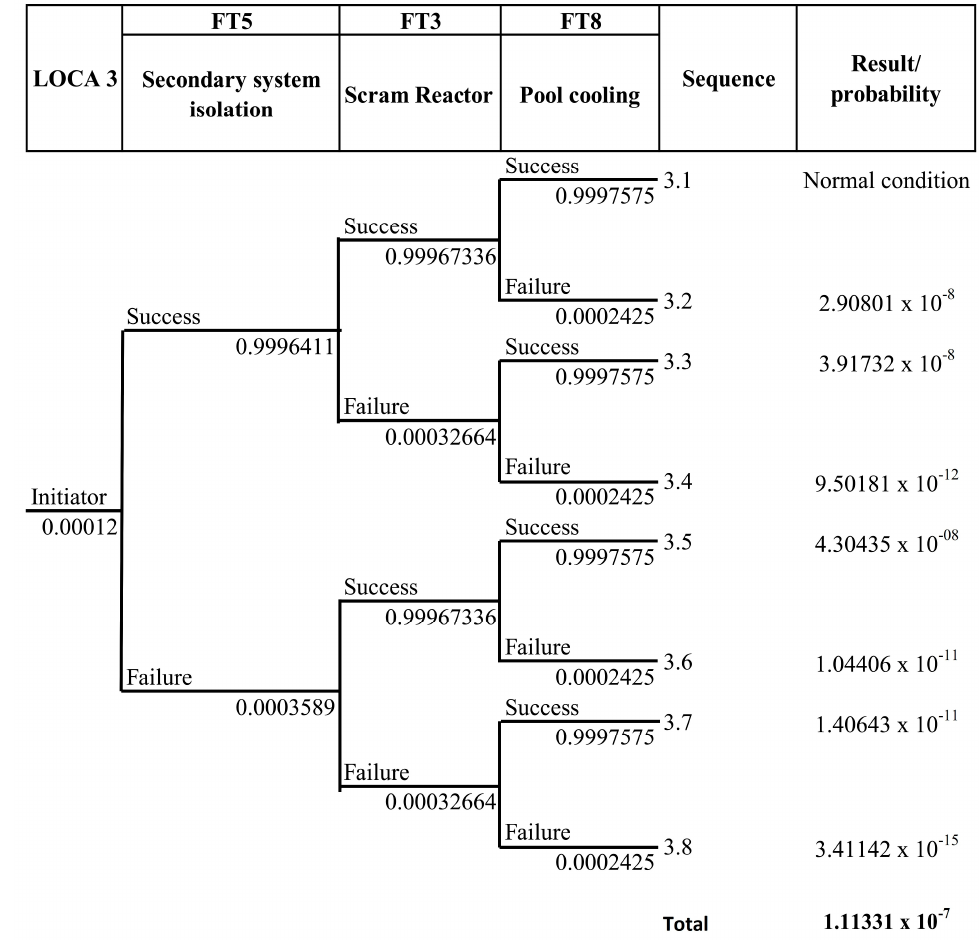
Figure 13. Energies 2020 , 13 , x FOR PEER REVIEW